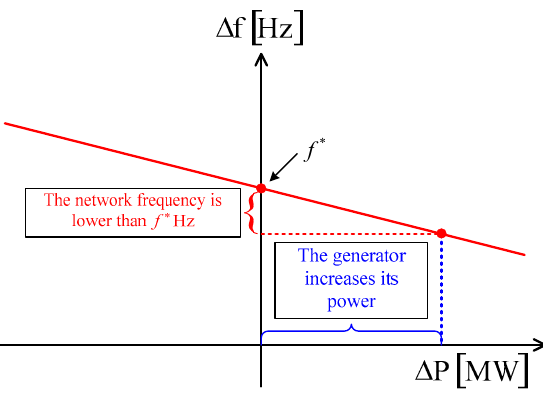
Figure 9. Concept of virtual synchronous generator (VSG) control.